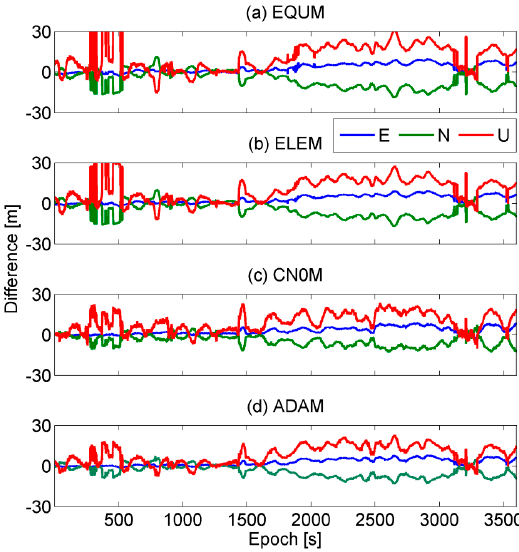
Figure 9. Positioning differences between the RTD solutions and the precise coordinates of dataset no. 1. ( a ) Results of the equal-weight model (EQUM); ( b ) results of the elevation model (ELEM); ( c ) results of the C/N0 model (CN0M); and ( d ) results of the adaptive model (ADAM).